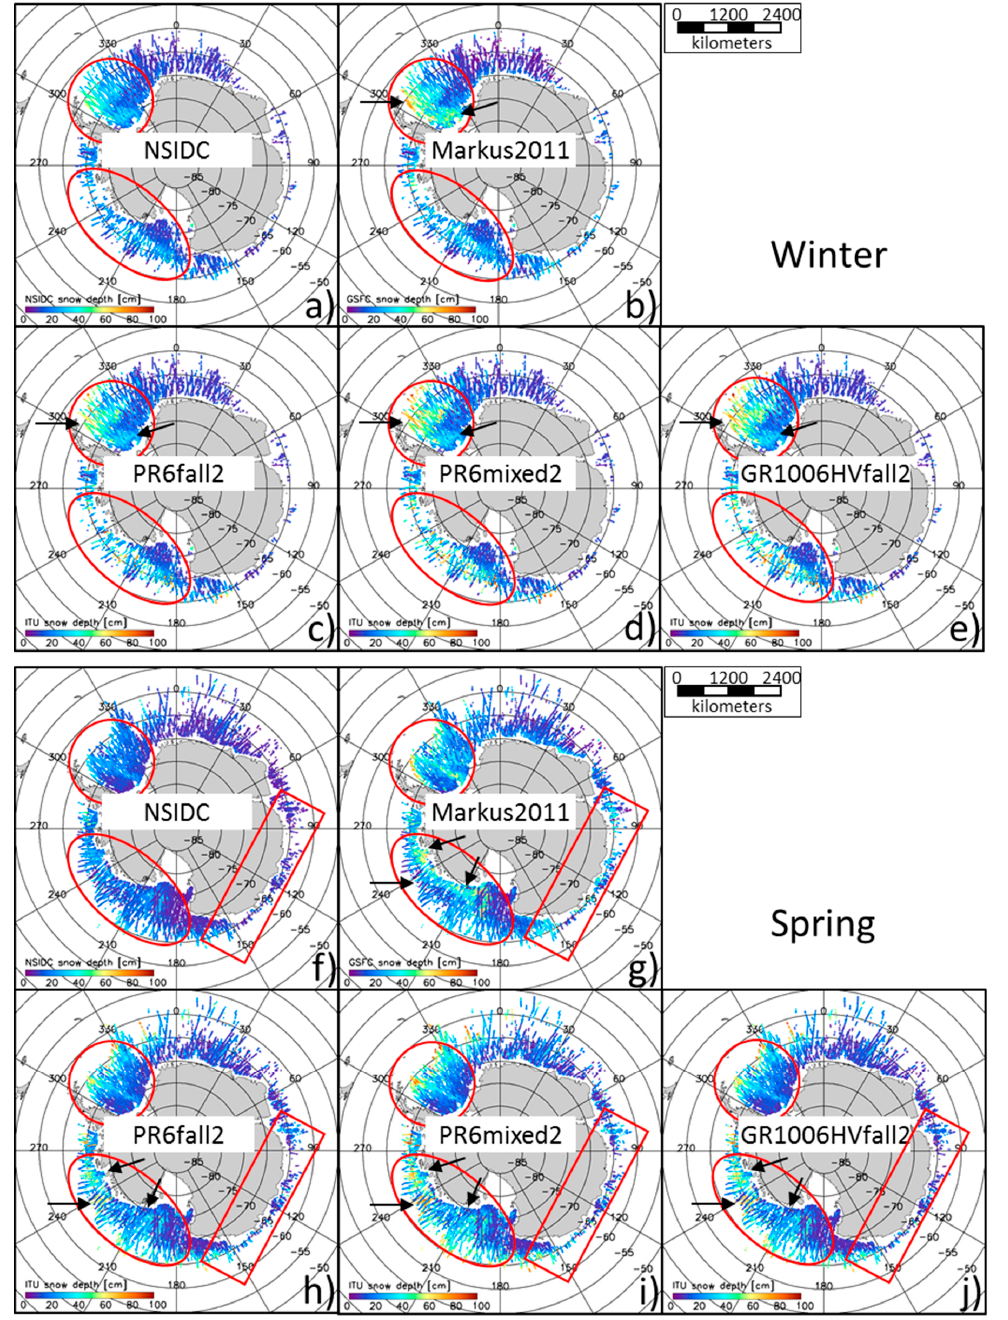
Figure 9. The snow depth computed from the AMSR-E data at the locations of the ICESat overpasses for winter (top) and spring (bottom); only days with an actual ICESat overpass are used (see Table 1). ( a , f ) show the NSIDC algorithm; ( b , g ) show the Markus2011 algorithm; ( c , h ) show the ITU algorithm (Equation (7)) based on the PR06 fall coe ffi cients; ( d , i ) and ( e , j ), are comparable to ( c ) and ( h ), but are based on the PR06 mixed coe ffi cients and GR1006HV fall coe ffi cients, respectively. See text for discussion of the red frames and black